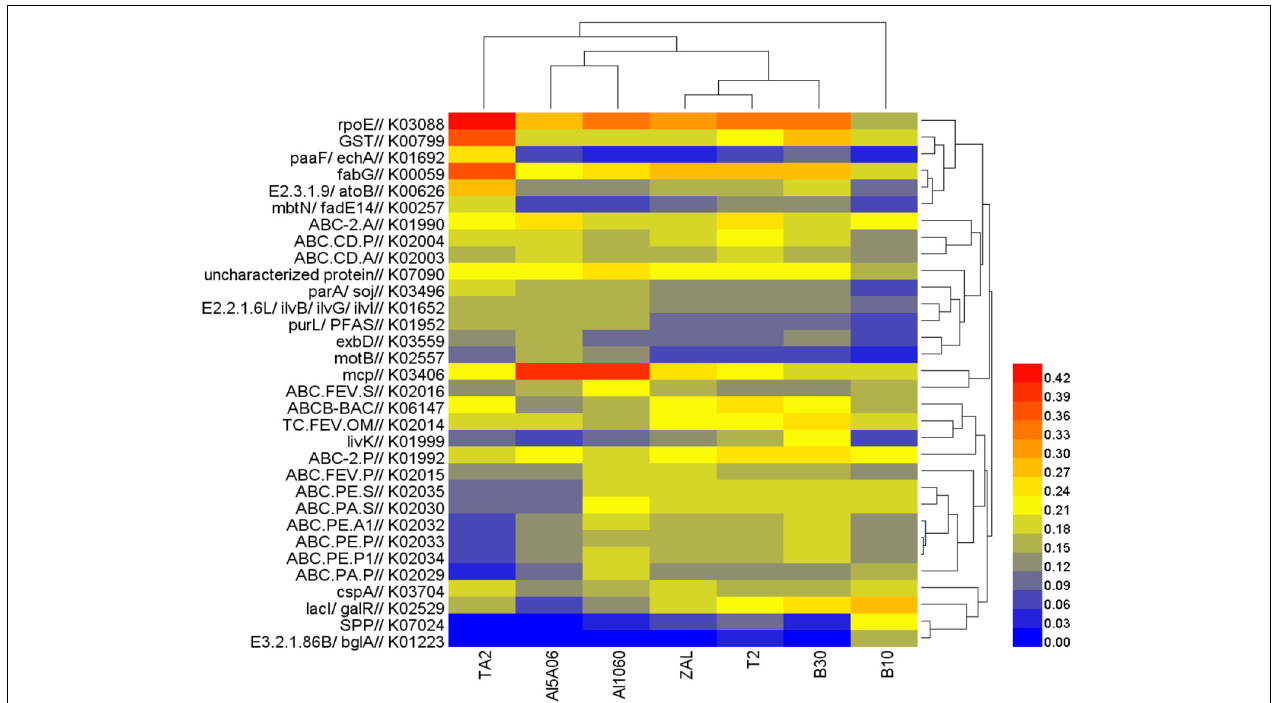
FIGURE 7 | Heat map of functional genes assigned with Kyoto Encyclopedia of Genes and Genomes database in the seven samples in Yap Trench using 16S rRNA gene sequencing (TA2, ZAL, Al5A06, Al1060, T2, B10, and B30 represented the biofilms collected from the corresponding alloy surfaces. The value of the color scale represents the relative abundance of functional genes).